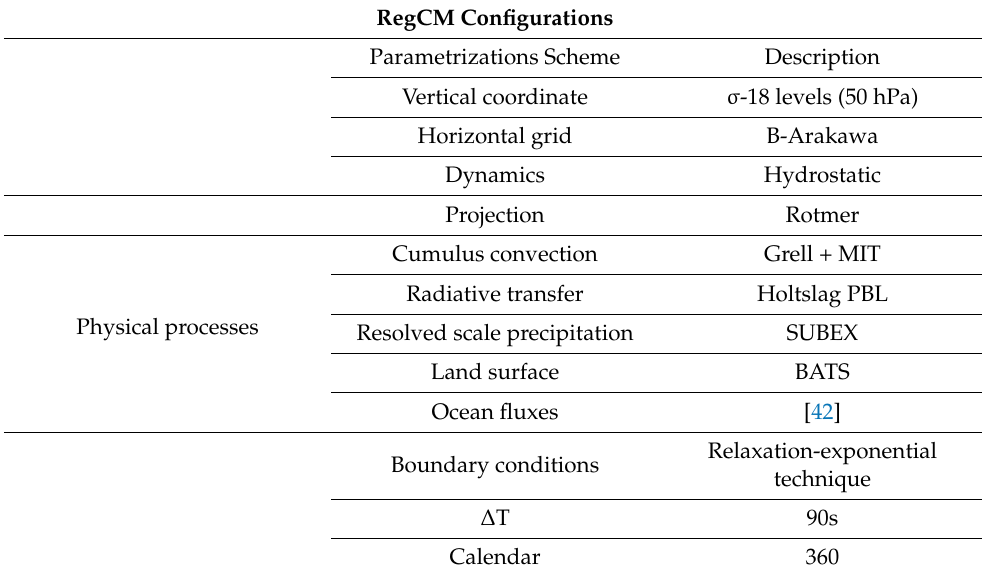
Table 1. Model setup and physics process applied to run the